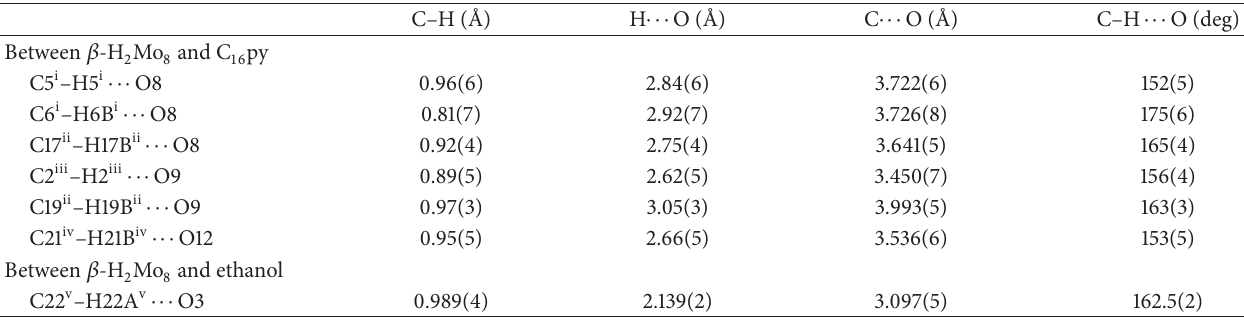
Table 2: C–H ⋅⋅⋅ O hydrogen bonds in C 16 py-H 2 Mo 8